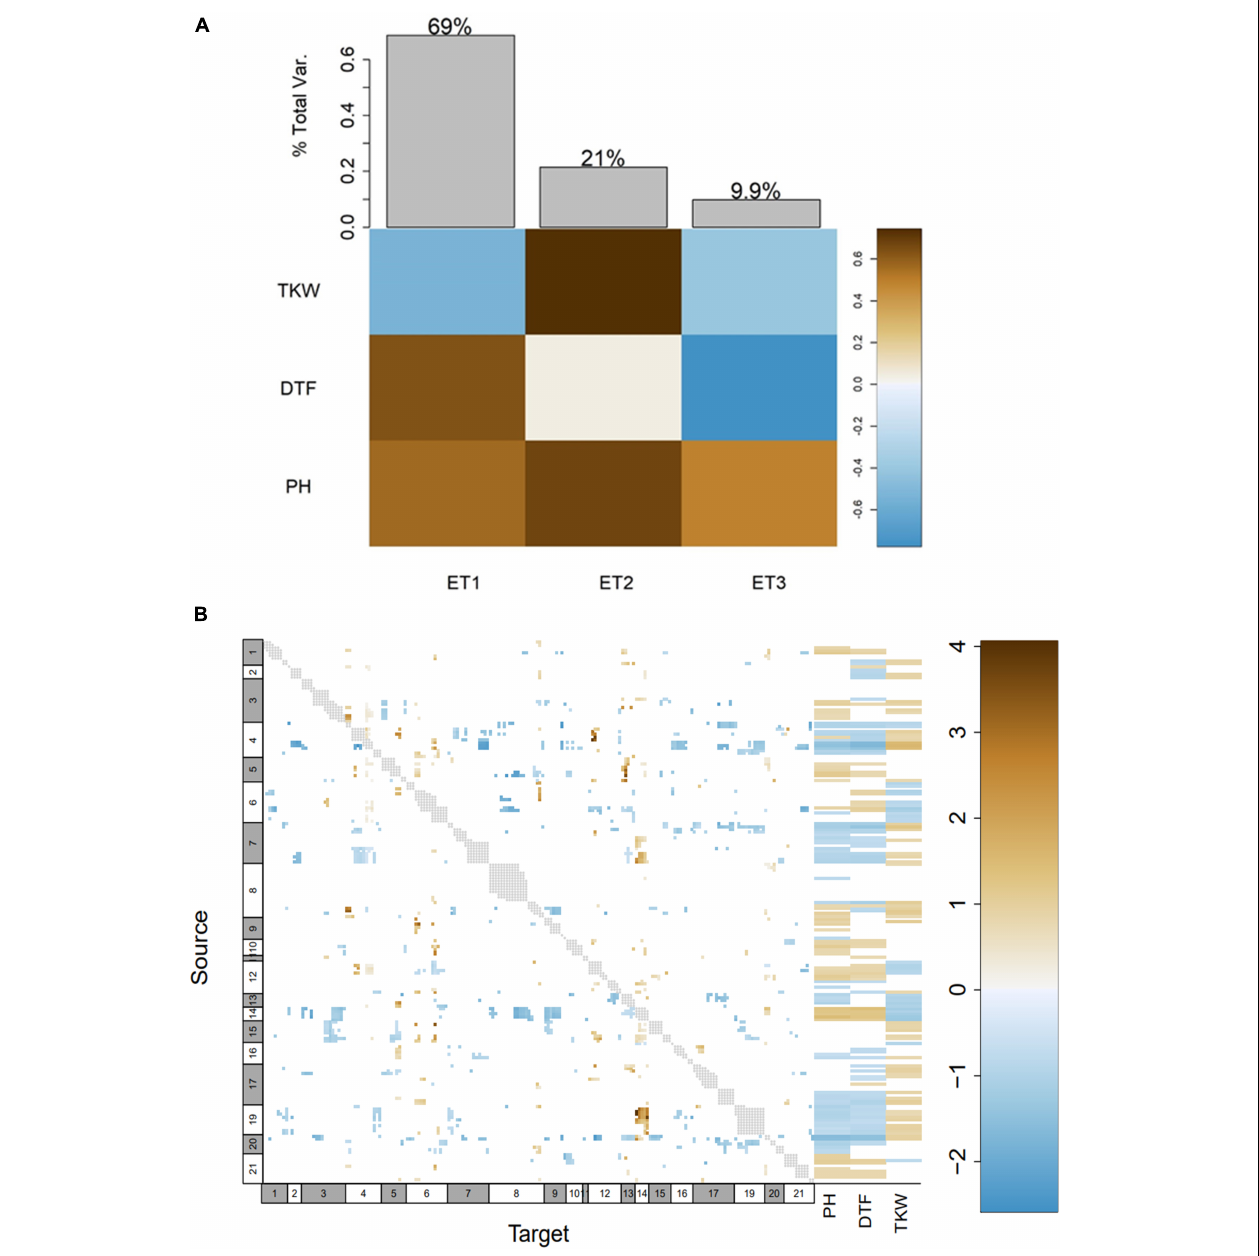
FIGURE 6 | Genome-wide epistasis analysis and effects of alleles at genome level on days to flowering (DTF), plant height (PH), and thousand kernel weight (TKW). (A) Decomposition of phenotypes into eigentraits (ET). Colors of the heatmap correspond to the global variance fraction of each ET. (B) Heatmap showing interactions between all pairs of alleles at genome level, resulting from a pairscan analysis. Every allele was assigned as “source” and “target” for the pairscan analysis. To the right of the heatmap, the interaction of every allele (assigned as source) on the phenotypes involved in the pleiotropy is shown. The heatmap scale represents the reparametrized coefficient calculated by the software and might be interpreted as the direction of the allelic effect. Gray dots show marker pairs that were not included in the pairwise scan due to complete linkage. Numbers at the x and y axes in white and gray boxes correspond to linkage groups.